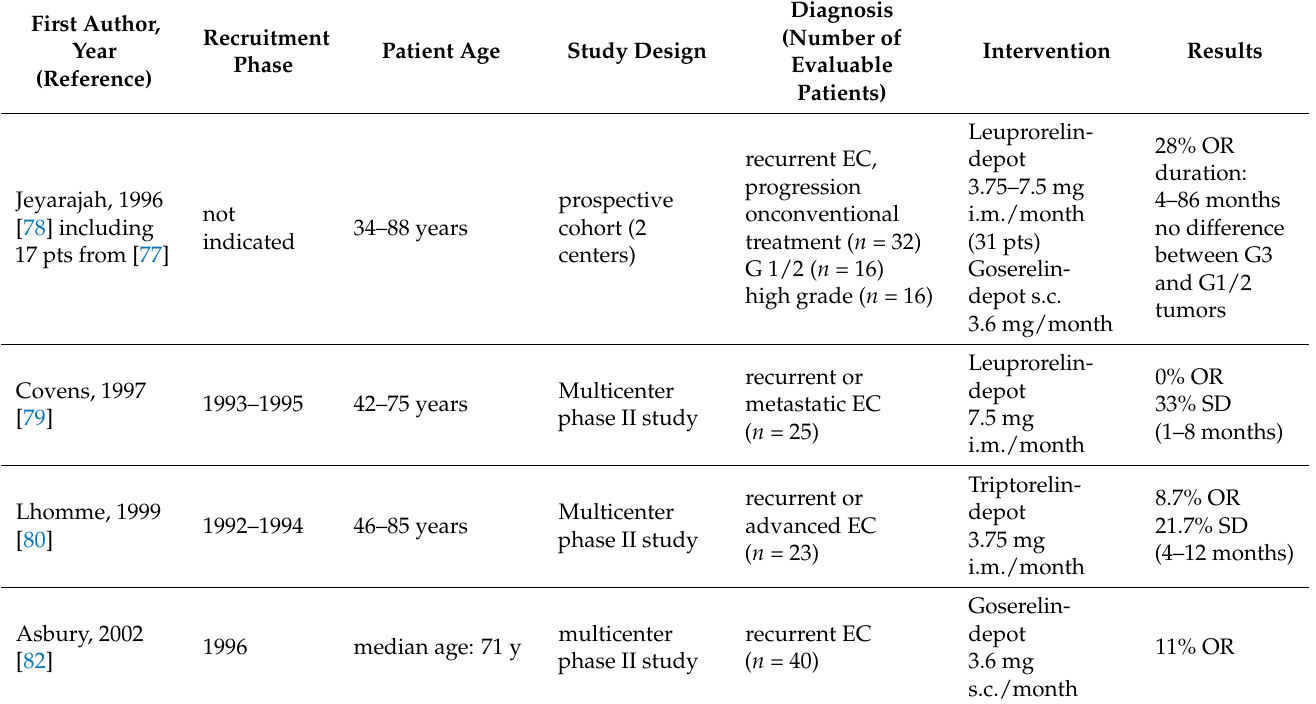
Table 2. Effects of GnRH-agonists (conventional doses) in patients with advanced or recurrent endometrial cancer